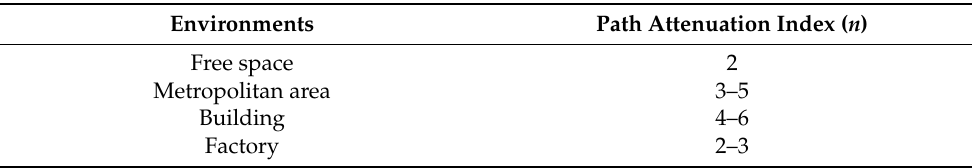
Table 1. The value of n in various